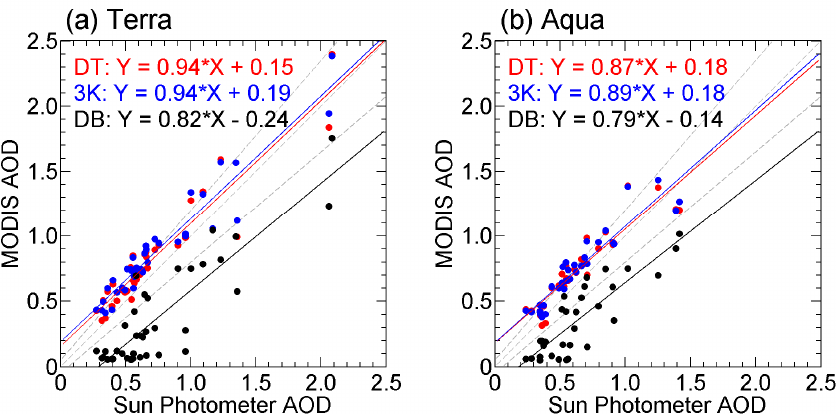
Figure 3. Scatterplots with the sun photometer AODs and MODIS AODs for ( a ) Terra and ( b ) Aqua. Only those AODs when both algorithms give retrievals with good quality are included. The red/blue/black dots represent MODIS AODs from the 10/3 km DT/DB algorithms. Corresponding linear regression lines and equations are present in red/blue/black solid lines and texts. The gray dashed lines are the expected errors (EE) of ±(0.05 + 15%) and 1:1 line.